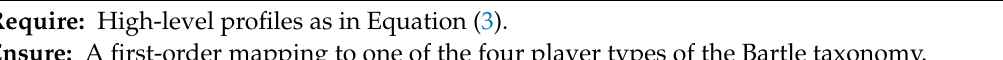
Algorithm 2 Mapping of high-level attributes to Bartle